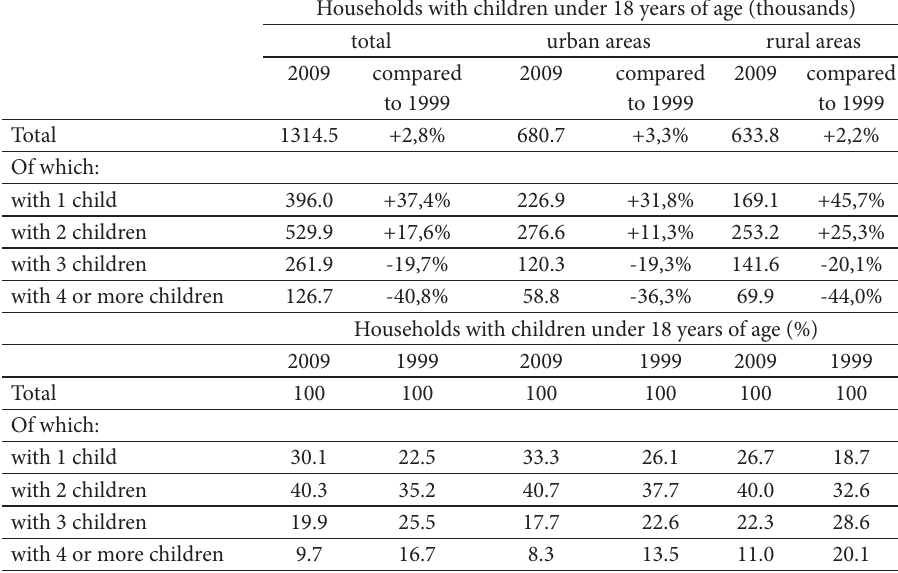
Table 1. Changes in the number of children in families between the 1999 and 2009 censuses. Households with children under 18 years of age (thousands) total urban areas rural